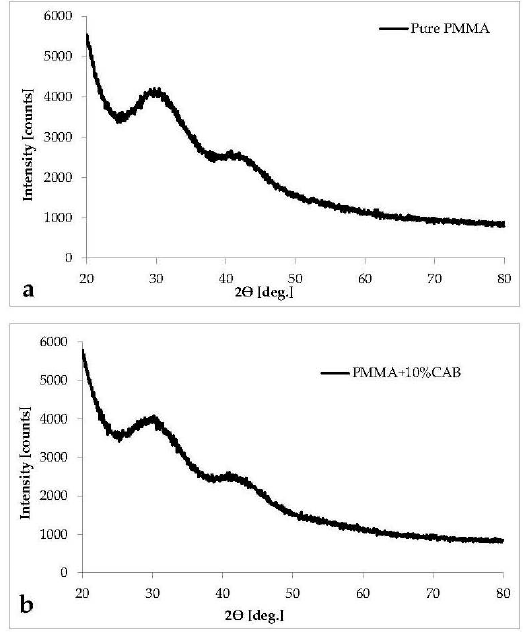
Figure 3. XRD pattern for: ( a ) pure PMMA, and ( b ) PMMA/10%CAB.